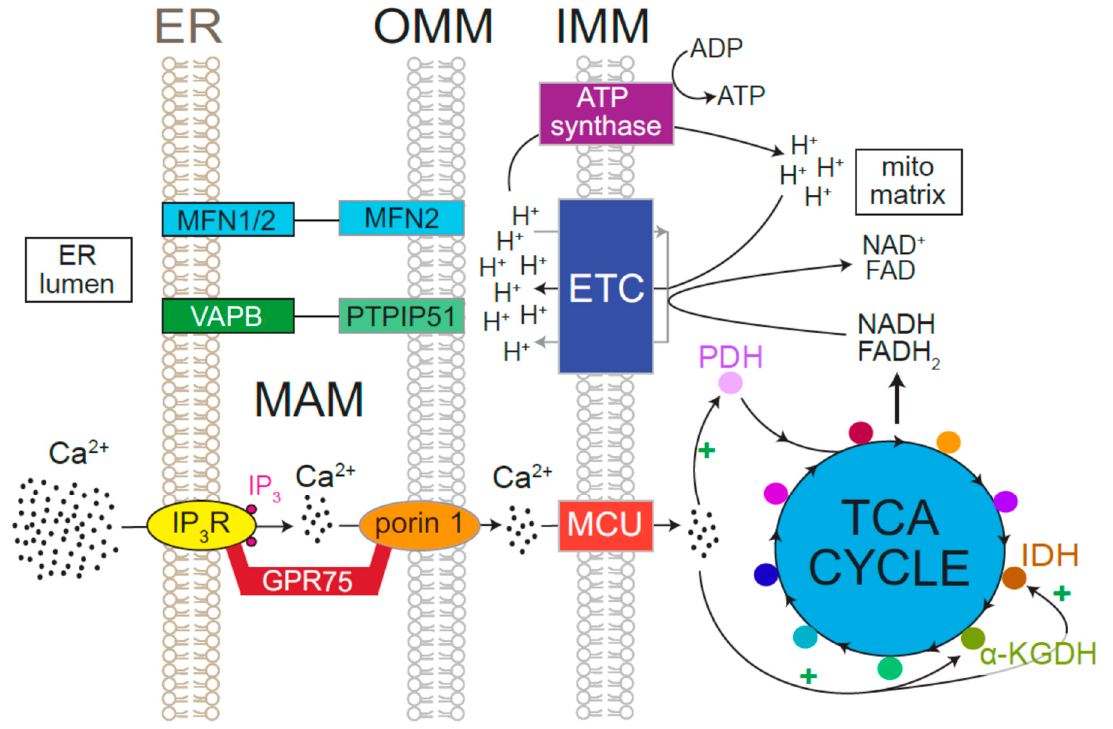
Figure 4. ER Ca 2 + release stimulates oxidative phosphorylation. Mitochondria-associated membranes (MAMs) are points of contact between the ER and mitochondria that have various functions, including Ca 2 + signaling between the two organelles. MAMs are stabilized by protein pairs that bind to each other, serving as molecular tethers. The VAPB-PTPIP51 and MFN1 / 2-MFN2 binding pairs are